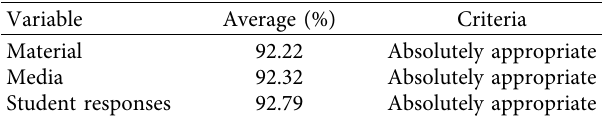
Table 7: Tryout result.